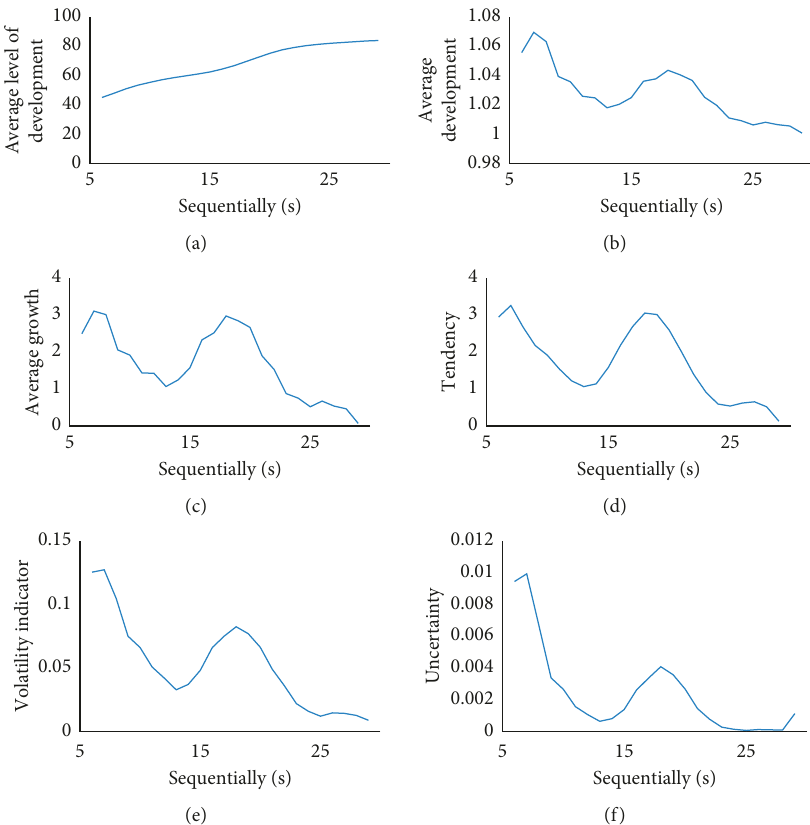
Figure 3: The analysis indexes of speed characteristic: (a) the average level of development of time sequentially, (b) the average development of time sequentially, (c) the average growth of time sequentially, (d) the tendency of time sequentially, (e) the volatility index of time sequentially, and (f) the uncertainty of time sequentially.